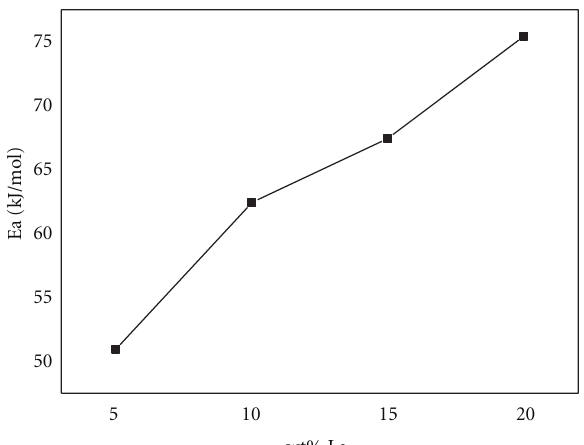
Figure 6: Relationship of activation energy ( Ea ) and La content.